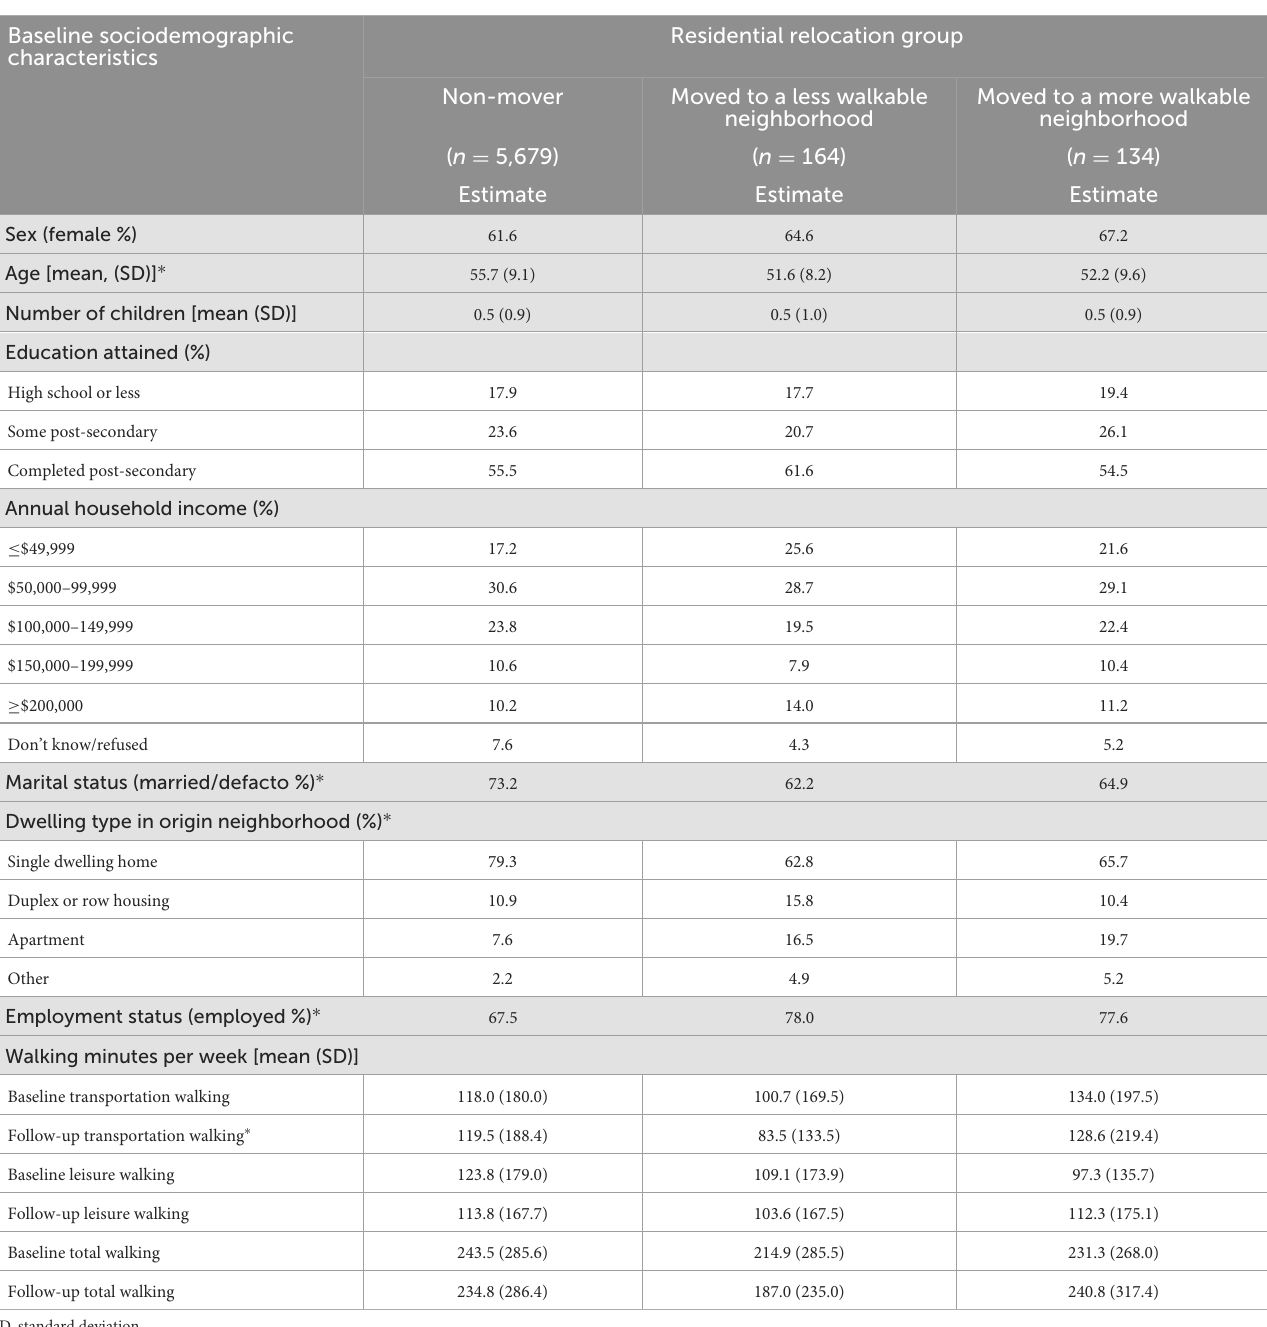
TABLE 1 Sample characteristics by residential relocation